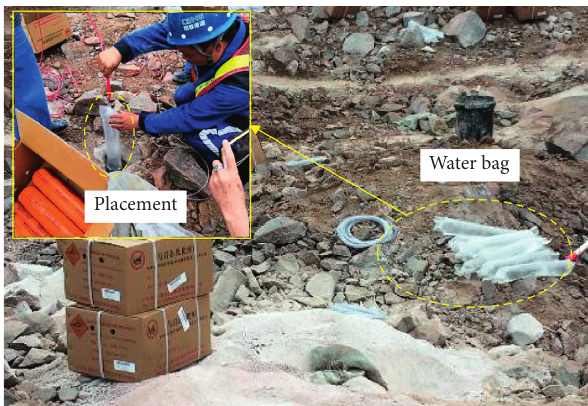
Figure 7: Placement of water bag in water-decked blasting.